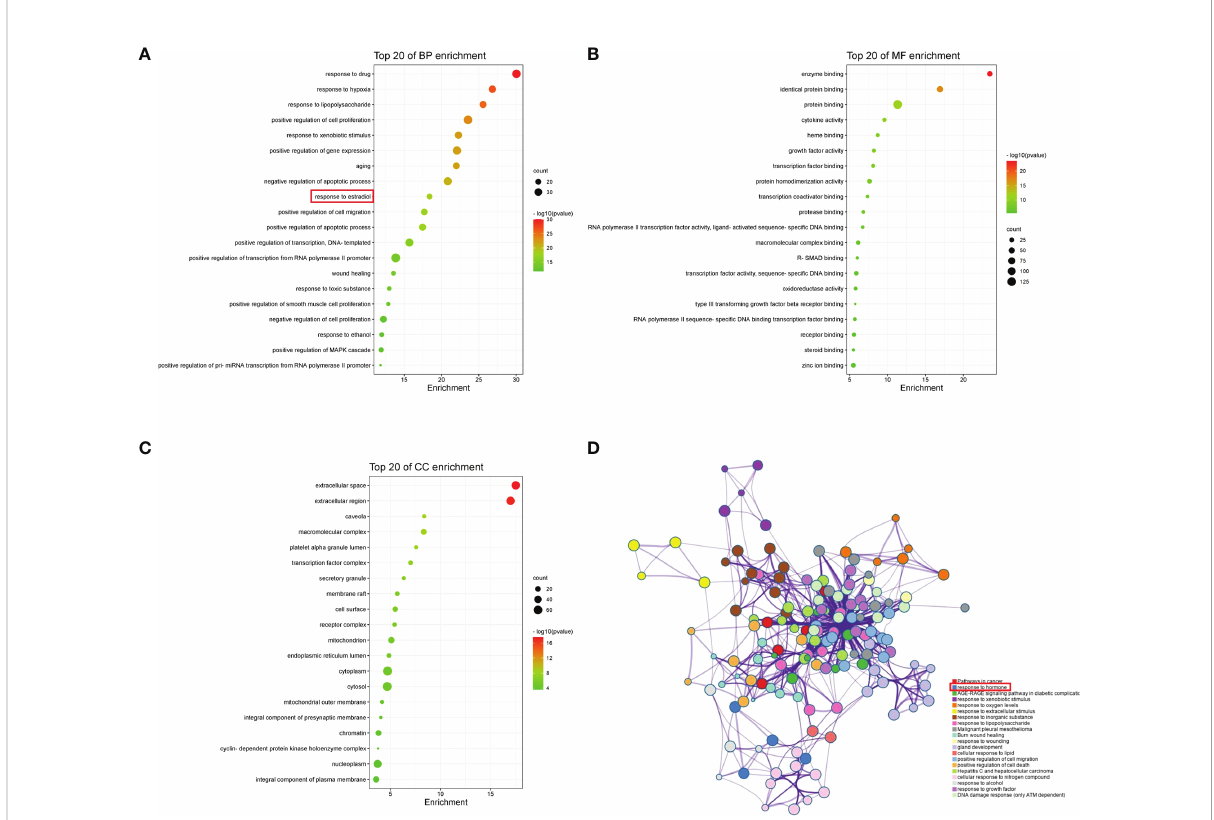
FIGURE 6 GO and pathway enrichment analyses of YHT. (A) Biological process. (B) Molecular function. (C) Cellular component. (D) Network of enriched